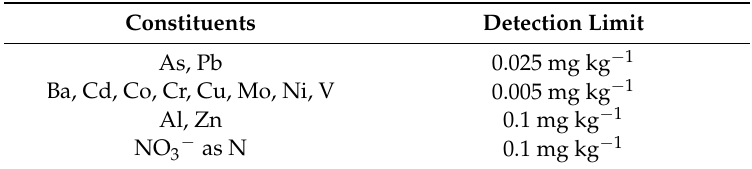
Table 1. Method detection limits for target pollutants (metals and NO 3 − ).